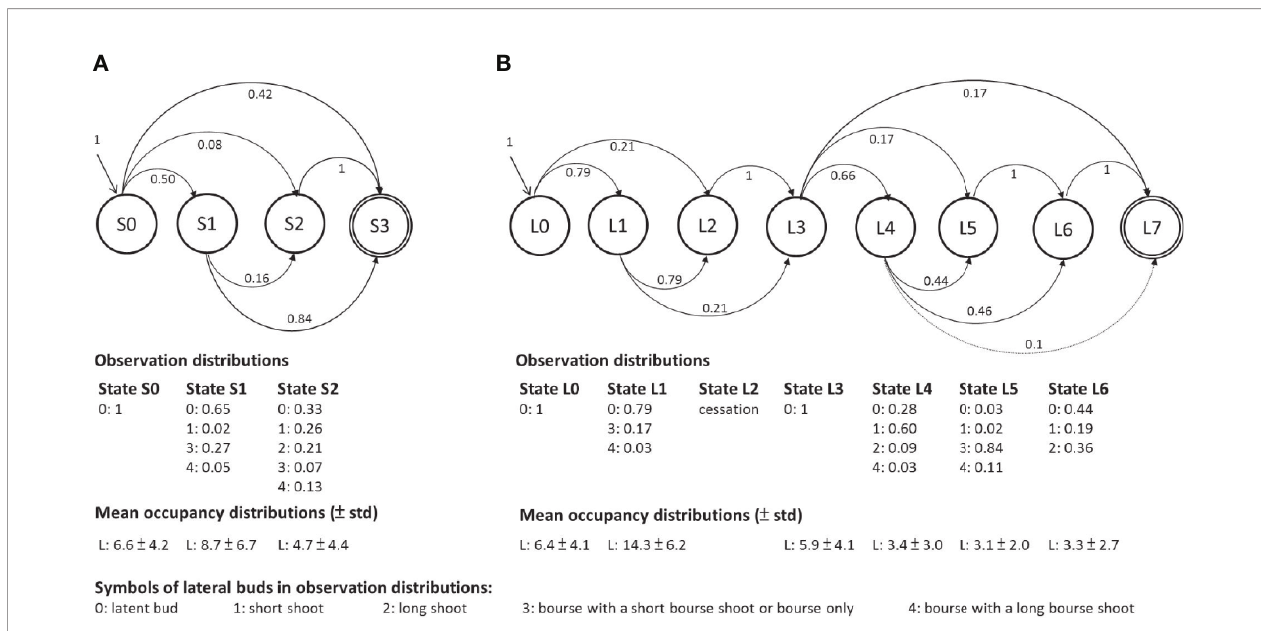
FIGURE 4 | Graphic representation of the two hidden semi-Markov chain models estimated on (A) the one-GU shoots with short or medium growth duration (GD) and (B) the one-GU shoots with long GD and two-GU shoots. The branching zones are modeled by transient states, represented by circles with a single line border while the fi nal absorbing states are represented by a double-line circle. Each state is associated with an observation distribution representing the speci fi c mixture of lateral types in a zone and an occupancy distribution representing the mean number of nodes of each zone. The leftmost state (state S0 and L0) is the initial zone at the base of a shoot. The transition from one zone to another is represented by an arrow, with its probability indicated nearby. Only transition probabilities greater than 0.01 are